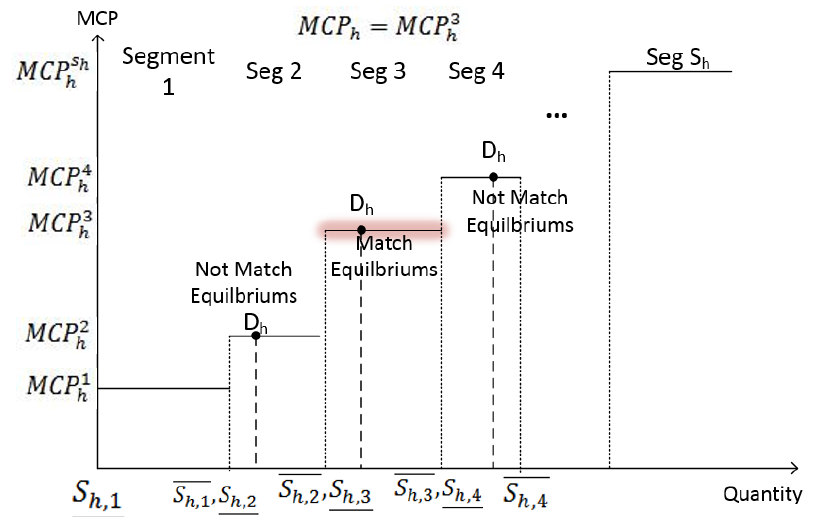
Figure 4. An example of the match equilibrium.